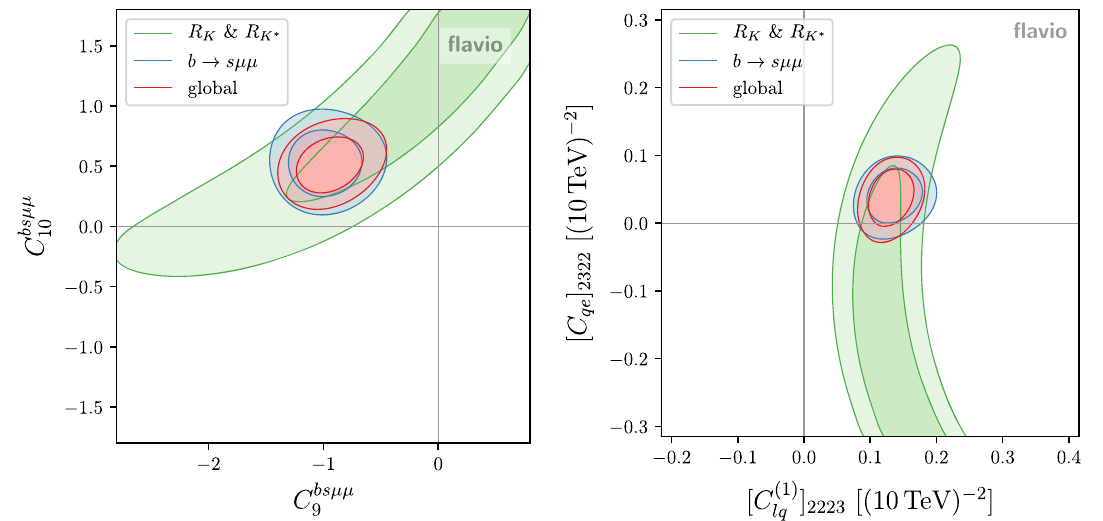
( 1 ) ] [ C ] cients [ C qe 2223 and 2322 at the scale 10 TeV. All other Wilson lq μμ coefficients are assumed to and 9